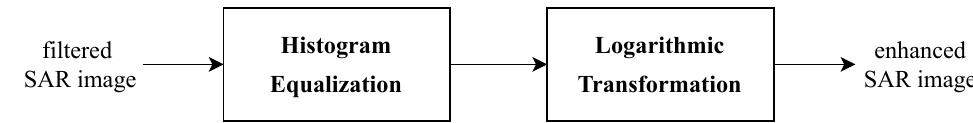
Figure 5. The two-level image enhancement